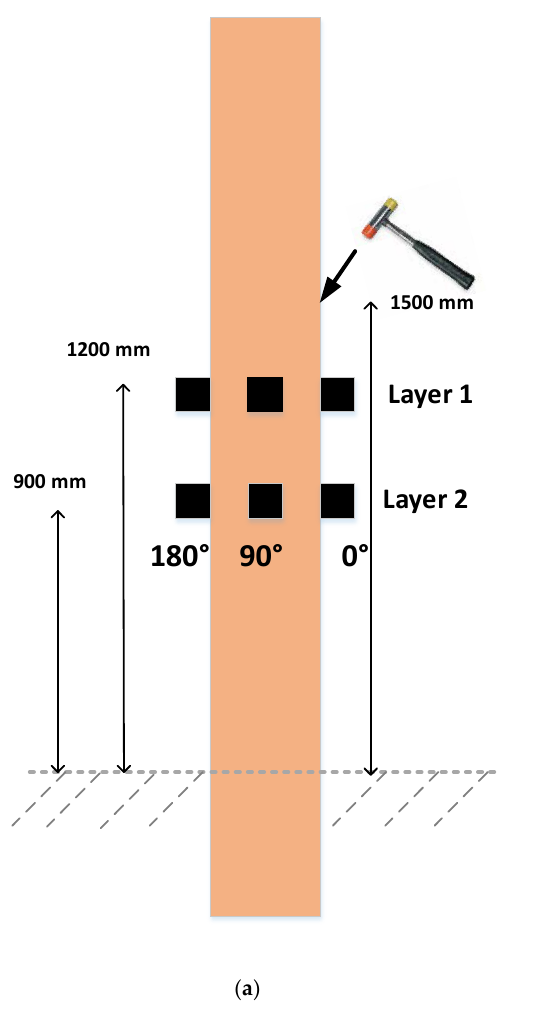
Figure 8. ( a ) Schematic diagram of experimental test set up ( b ) Horizontal cross section.